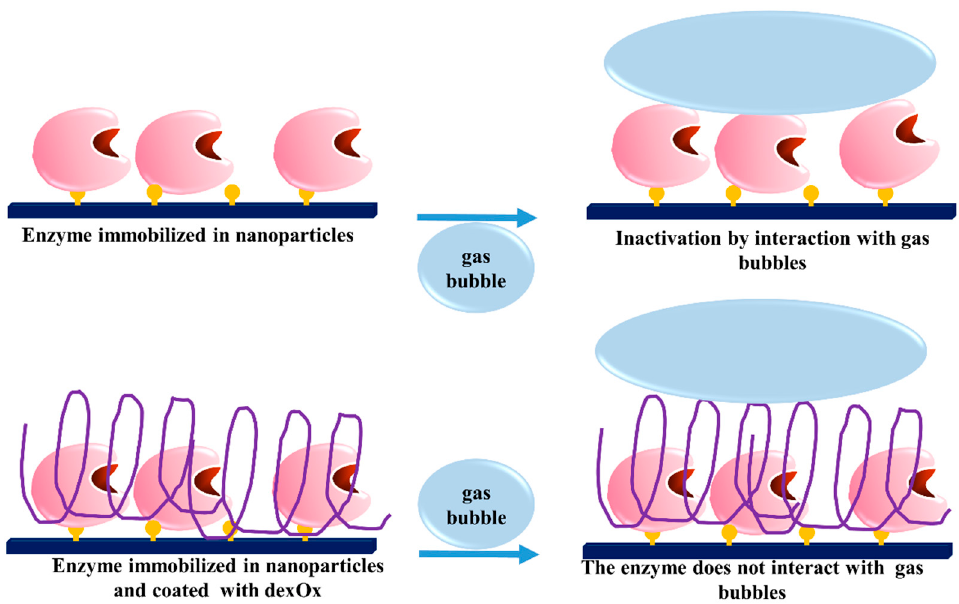
Figure 8. Coating of enzymes immobilized on non-porous nanoparticles with dexOx protects the enzyme from interactions with hydrophobic surfaces.